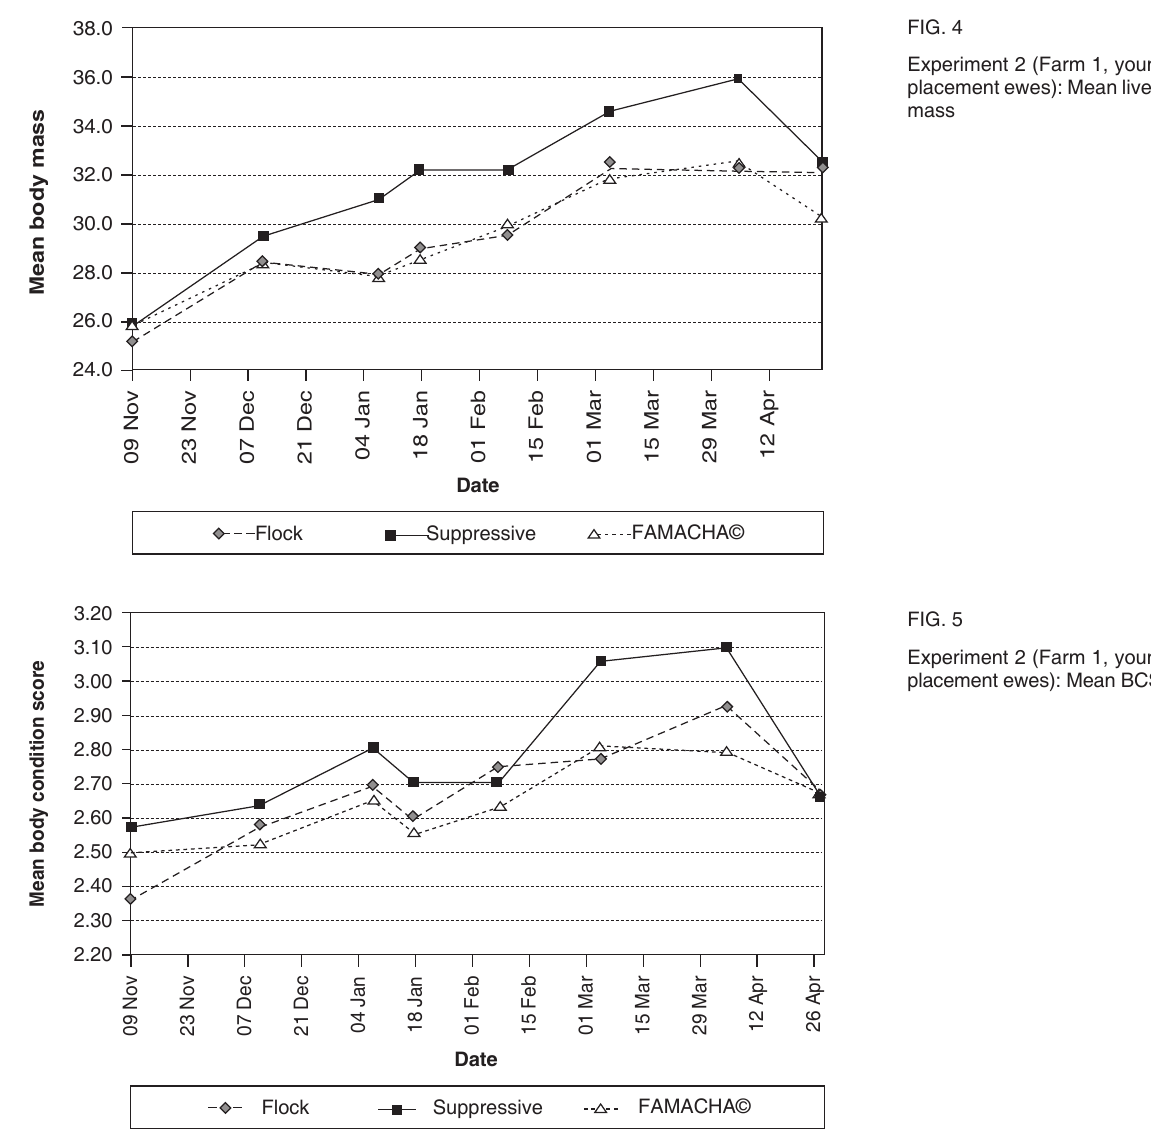
Experiment 2 (Farm 1, young re- placement ewes): Mean live body mass